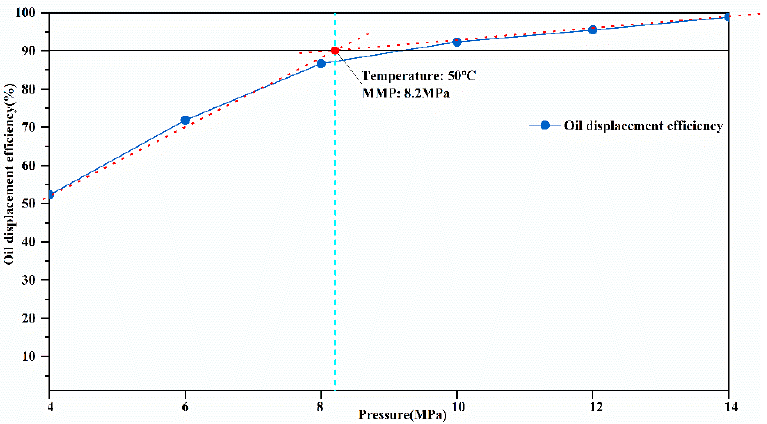
Figure 4. Diagram of minimum miscible pressure measured by slim tube experiment.